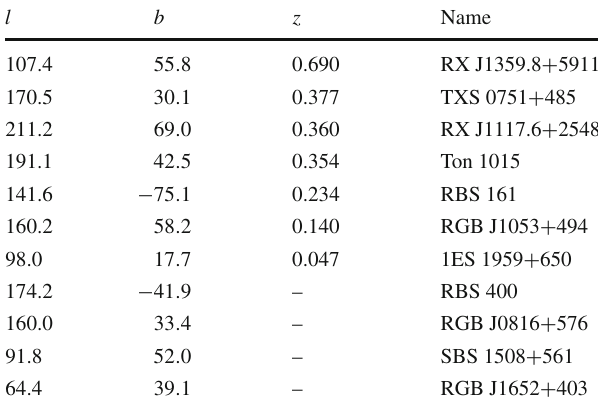
Table 2 Galactic coordinates (in degrees), redshifts (when measured) and names of 11 BL Lac type objects correlating with UHE air showers